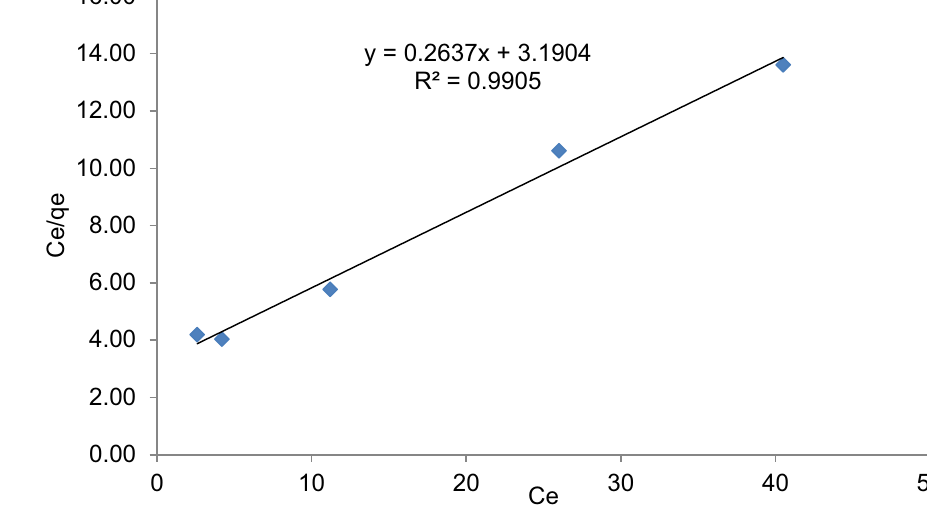
Fig. 7 Langmuir adsorption isotherm plot of Cr(VI) ion